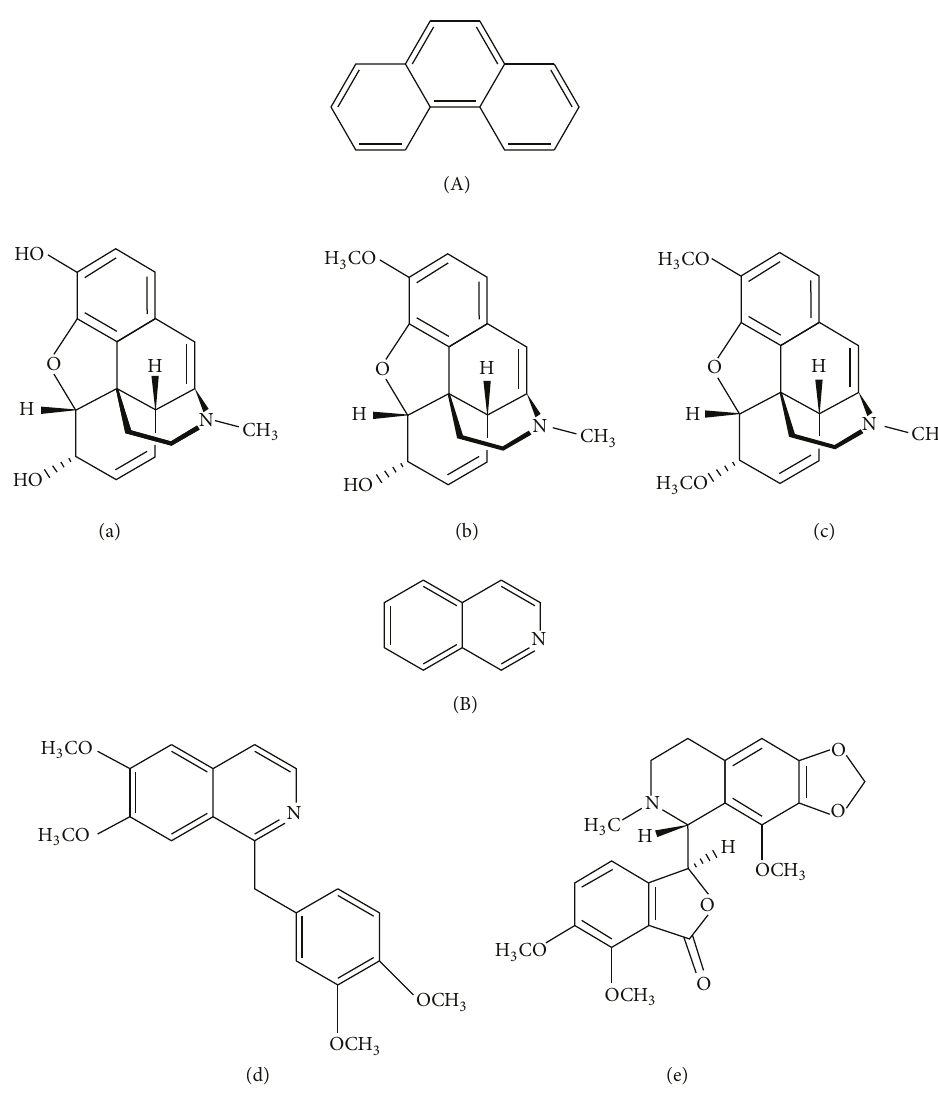
Figure 11: The main structures of phenanthrene and isoquinoline [21,